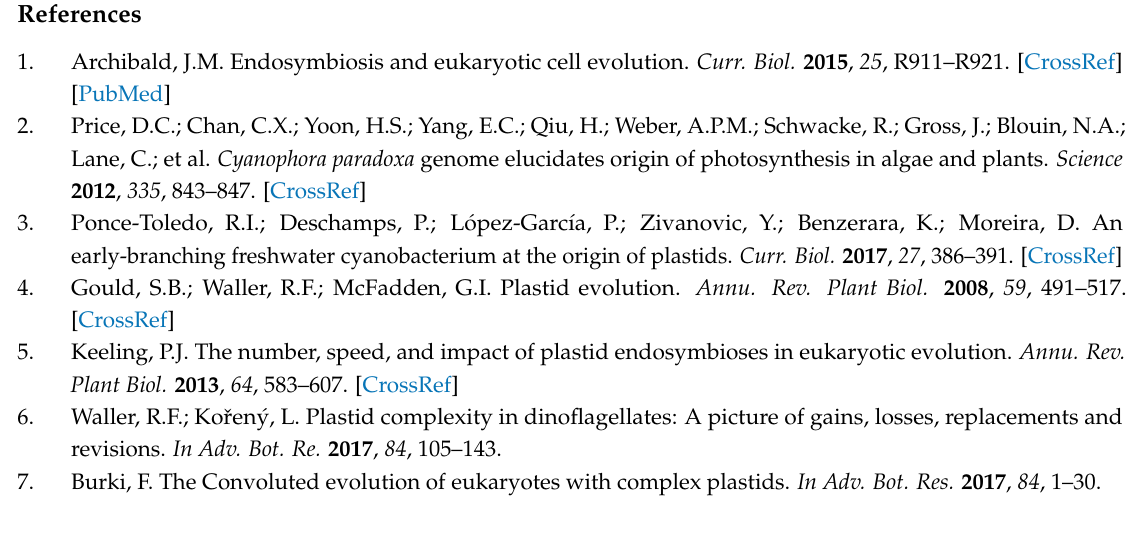
Table S1: In silico prediction of subcellular localization of